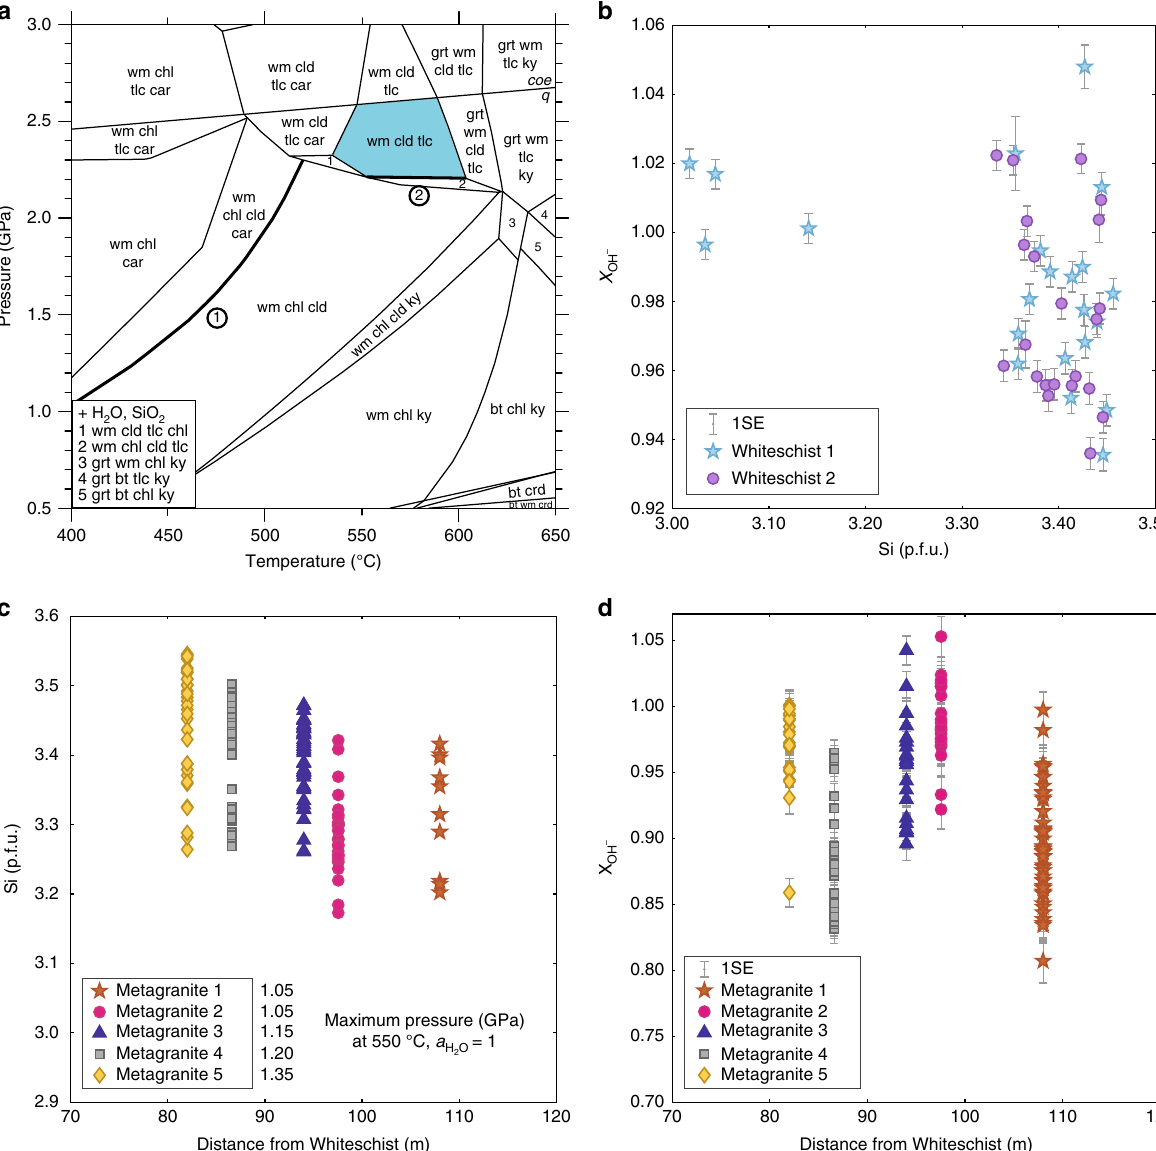
Fig. 2 Equilibrium phase diagram of whiteschist and phengite composition in whiteschist and metagranite samples. a Whiteschist thermodynamic calculation in the system KFMASH, using DOMINO software and the Berman database 20 (1988, 92 update), with the peak-pressure – temperature fi eld in blue. H 2 O-saturated conditions were used with the following composition in moles: Si (61.79), Al (20), Fe (2.23), Mg (12.17), and K (3.82). Mineral abreviations are as follows: bt: biotite; car: carpholite; chl: chlorite; crd: cordierite; cld: chloritoid; grt: garnet; ky: kyanite; opx: orthopyroxene; tlc: talc; wm: white mica. Bold lines labelled with (1) and (2) indicate dehydration reactions considered in the discussion. b OH − content in phengites in two whiteschist samples vs. silica (Si) content per formula unit (p.f.u.). Error bars represent the propagated uncertainty (1 SE) of the SE of the SIMS analyses, the SE of the reference material used for SIMS analyses, and the uncertainty on the electron microprobe measurements. c Silica (Si) content of white mica per formula unit (p.f.u.) in metagranite is plotted vs. the distance of the corresponding metagranite from the whiteschist body. The maximum pressure for the corresponding silica content is indicated assuming a temperature of 550 °C and a H 2 O activity (a H2O ) of 1. d OH − content in phengites in metagranites vs. the distance of the corresponding metagranite from the whiteschist body. Error bars represent the propagated uncertainty (1 SE) of the SE of the SIMS analyses, the SE of the reference material used for SIMS analyses, and the uncertainty on the electron microprobe measurements. Note that H 2 O activities >1 in b and d result from the accumulated uncertainty related to SIMS H 2 O content measurement and electron microprobe major elements